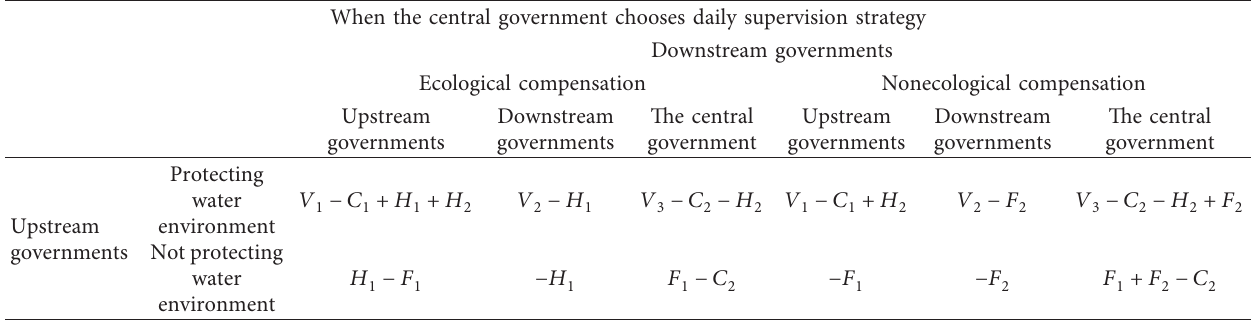
Table 2: The payoff matrix of each player with daily